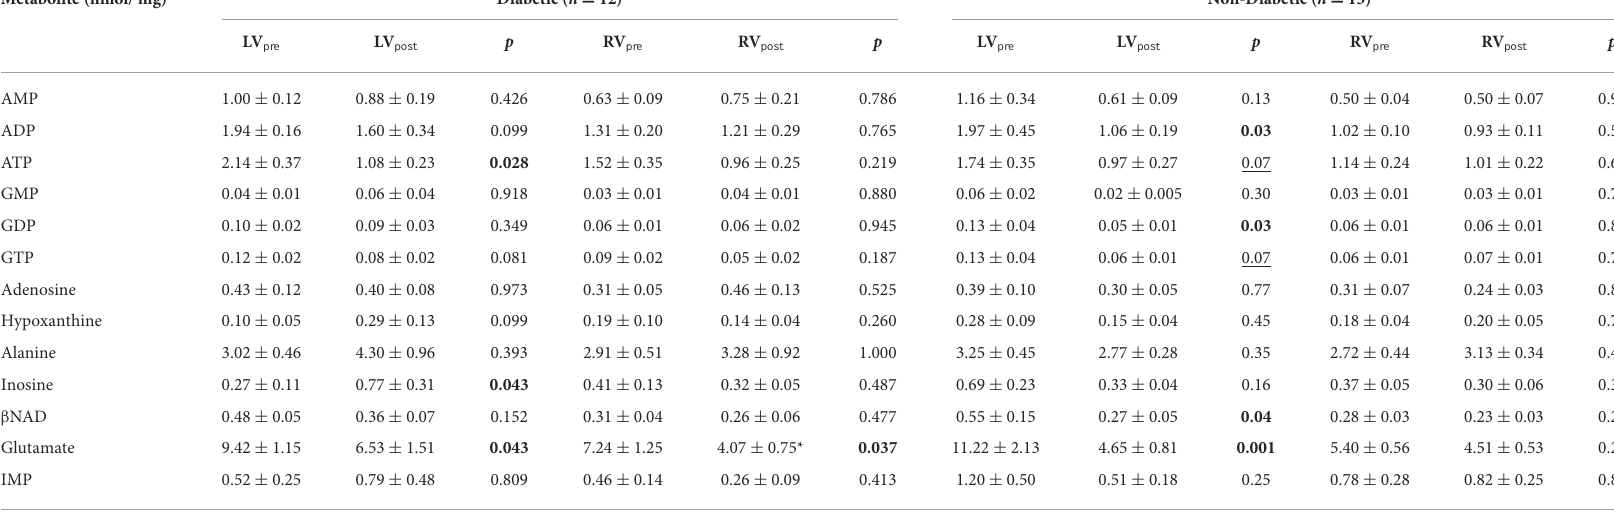
TABLE 4 Concentration of metabolites before and after surgery in LV and RV of diabetic and non-diabetic CABG patients. Metabolite (nmol/ mg) Diabetic( n =